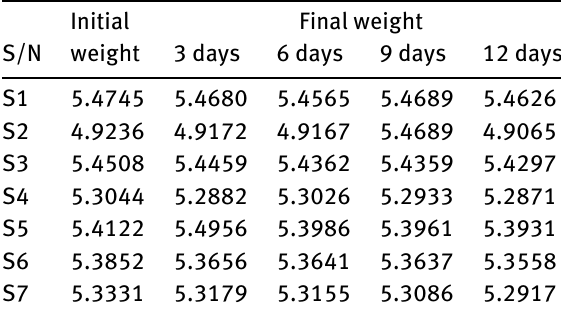
Table 3: Result of final weight.